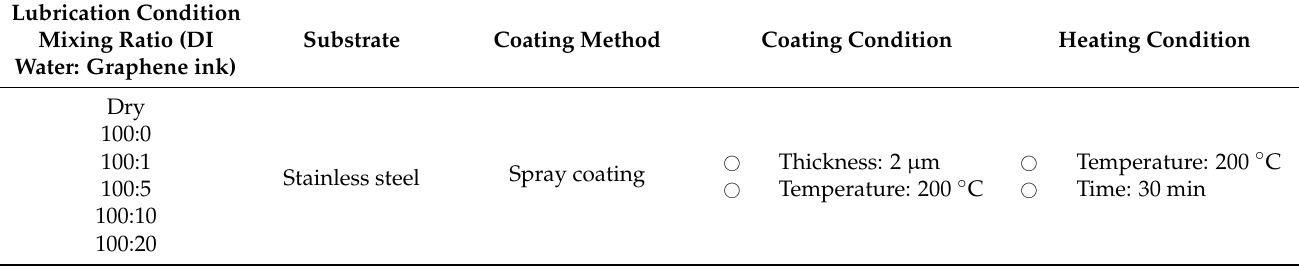
Table 1. Coating fabrication and lubrication